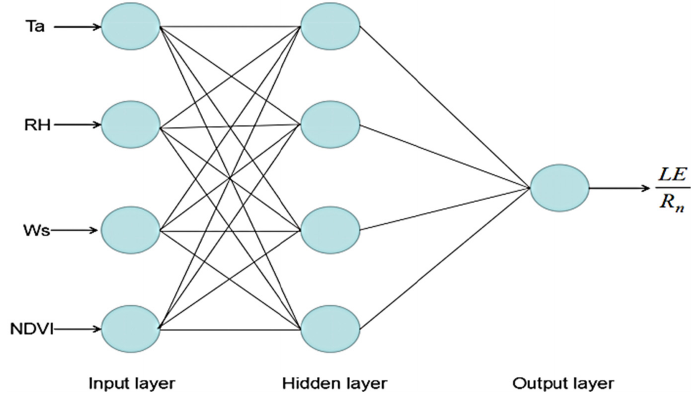
Figure 1. Architecture of the neural network model used in this study.